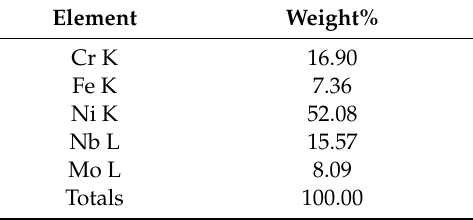
Table 5. EDX, spectrum 2.